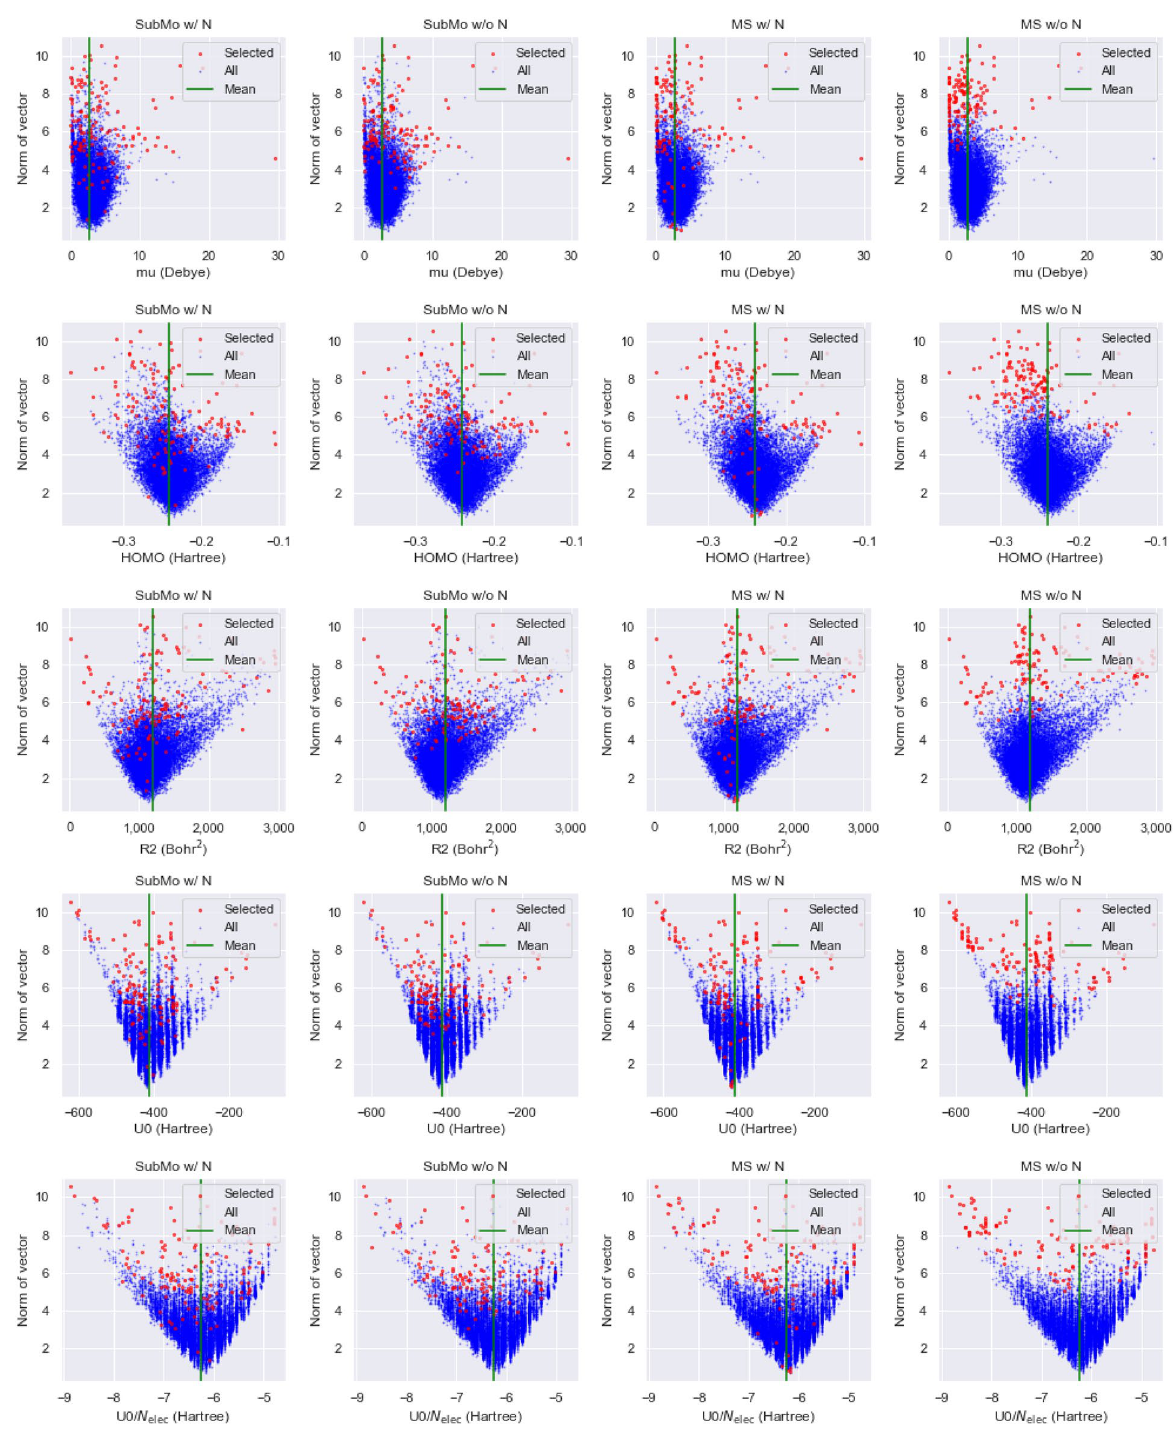
Figure 8. Scatter plots of norms vs. property values. Blue points correspond to all molecules in the test dataset, and red points indicate molecules selected by each